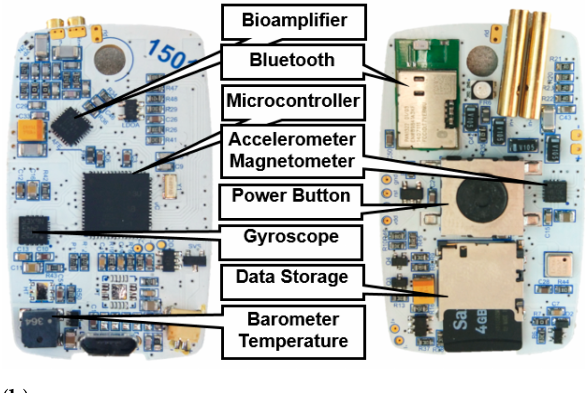
Figure 4. Usage of heterogeneous sensor systems: ( a ) A system utilizing ECG (electrocardiogram), temperature, GSR (galvanic skin response), and PPG (photo-plethysmograph) sensors [7]. ( b ) A system utilizing an accelerometer, a magnetometer, a gyroscope, a barometer, and a temperature sensor